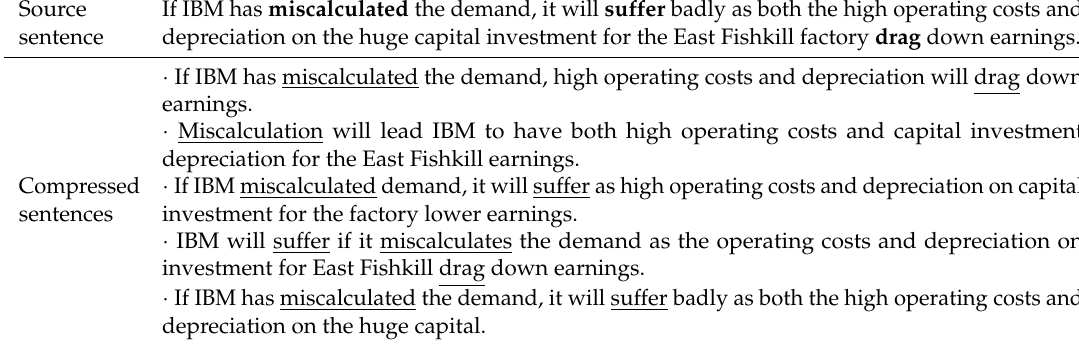
Table 1. An example of a source sentence and its compressed sentences in MSR dataset.